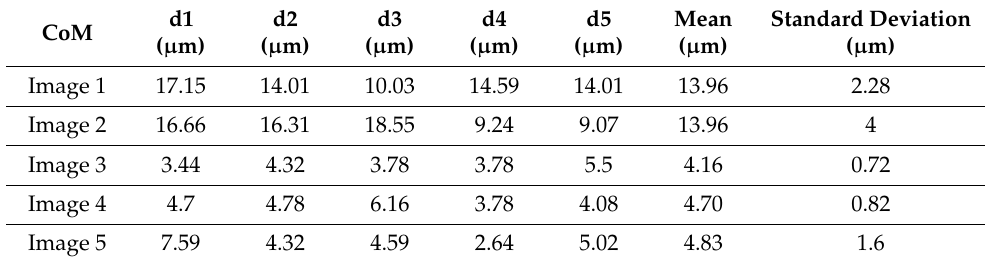
Table 7. Measurements of the gap present at the joint between the components of the assembly ( µ m) of prosthetic frameworks made by the casting over metal